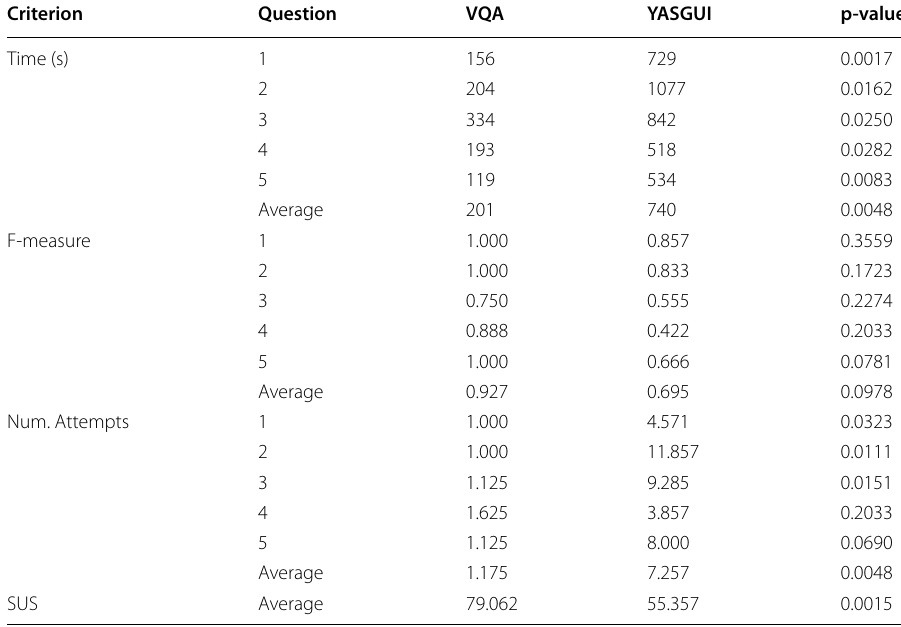
Table 2 Results of the VQA usability evaluation